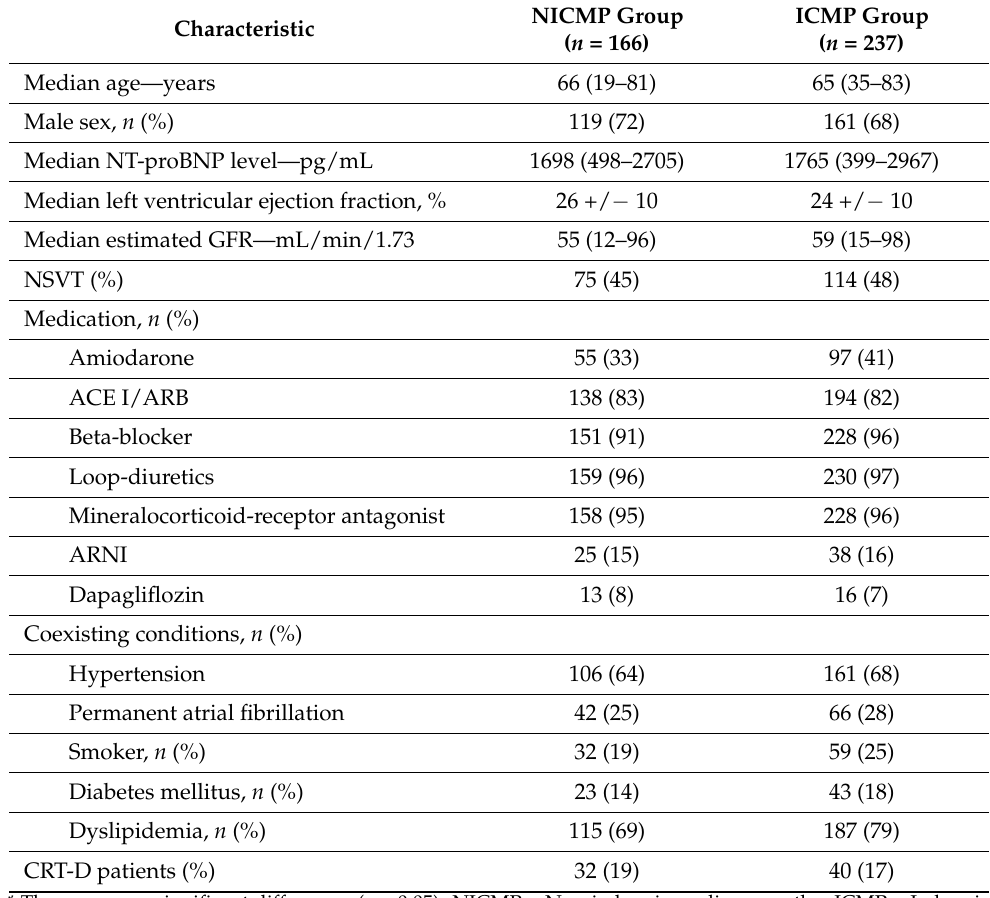
Table 1. Baseline characteristic of patients with ICD